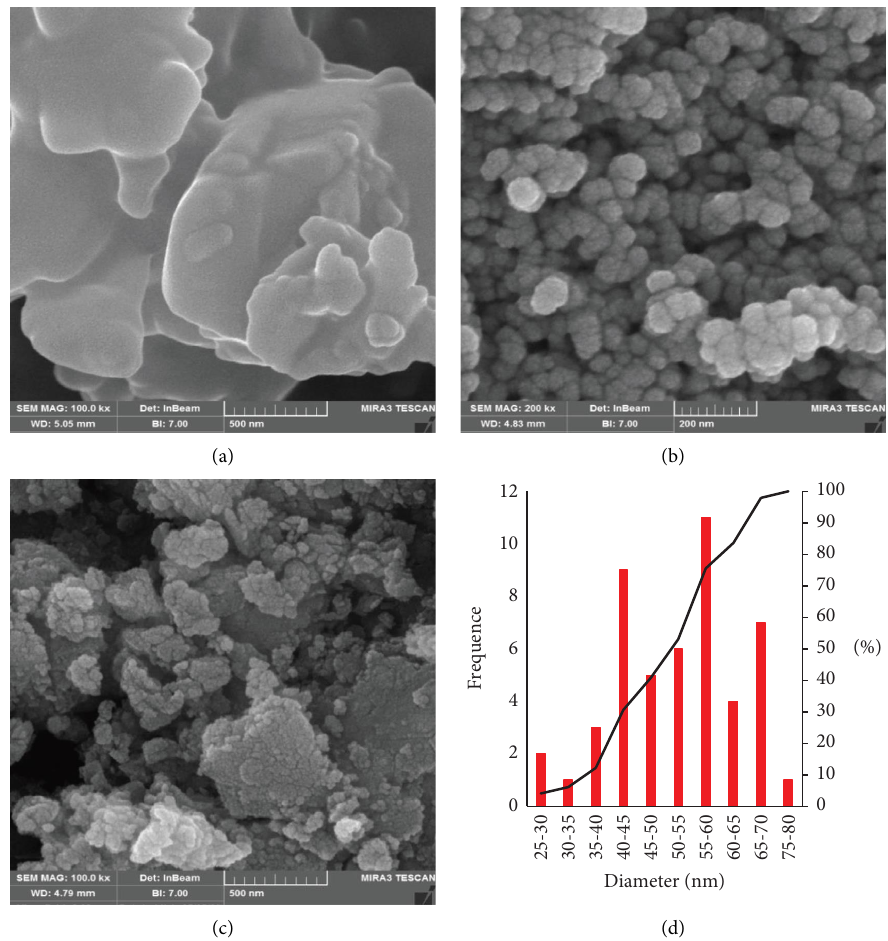
Figure 3: Scanning electron microscopy images of alginate biopolymers (a), zirconia NPs (b), alginate/zirconia nanocomposites (c), and the histogram of particle size distribution curves of zirconia NPs